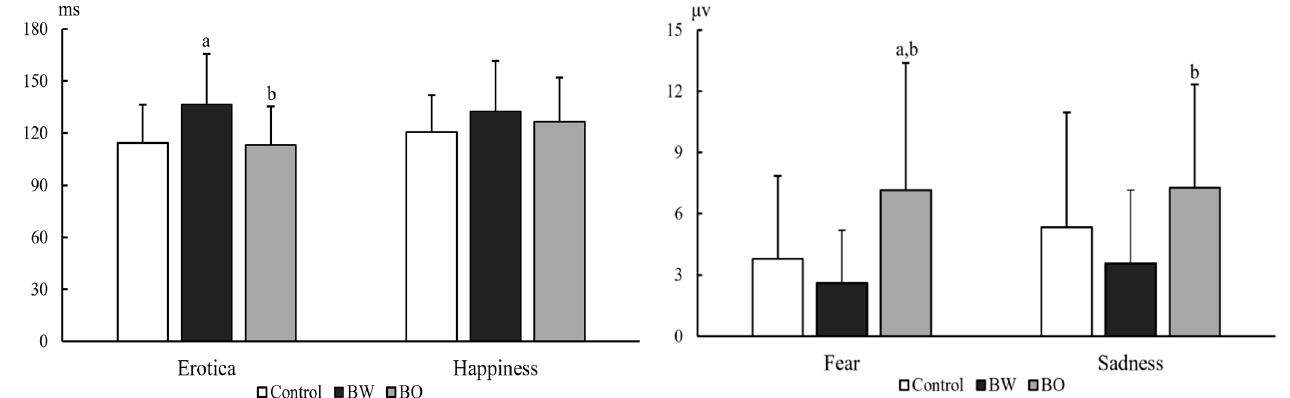
Figure 3. N1 latencies under Erotica and Happiness (left graph), and P3b amplitudes under Fear and Sadness (right graph) at Cz in healthy volunteers (Controls, n = 54), bipolar I disorder patients with (BW, n = 27) and without (BO, n = 26) hypersexuality. Notes: a, p < 0.05 versus controls; b, p < 0.05 versus BW.